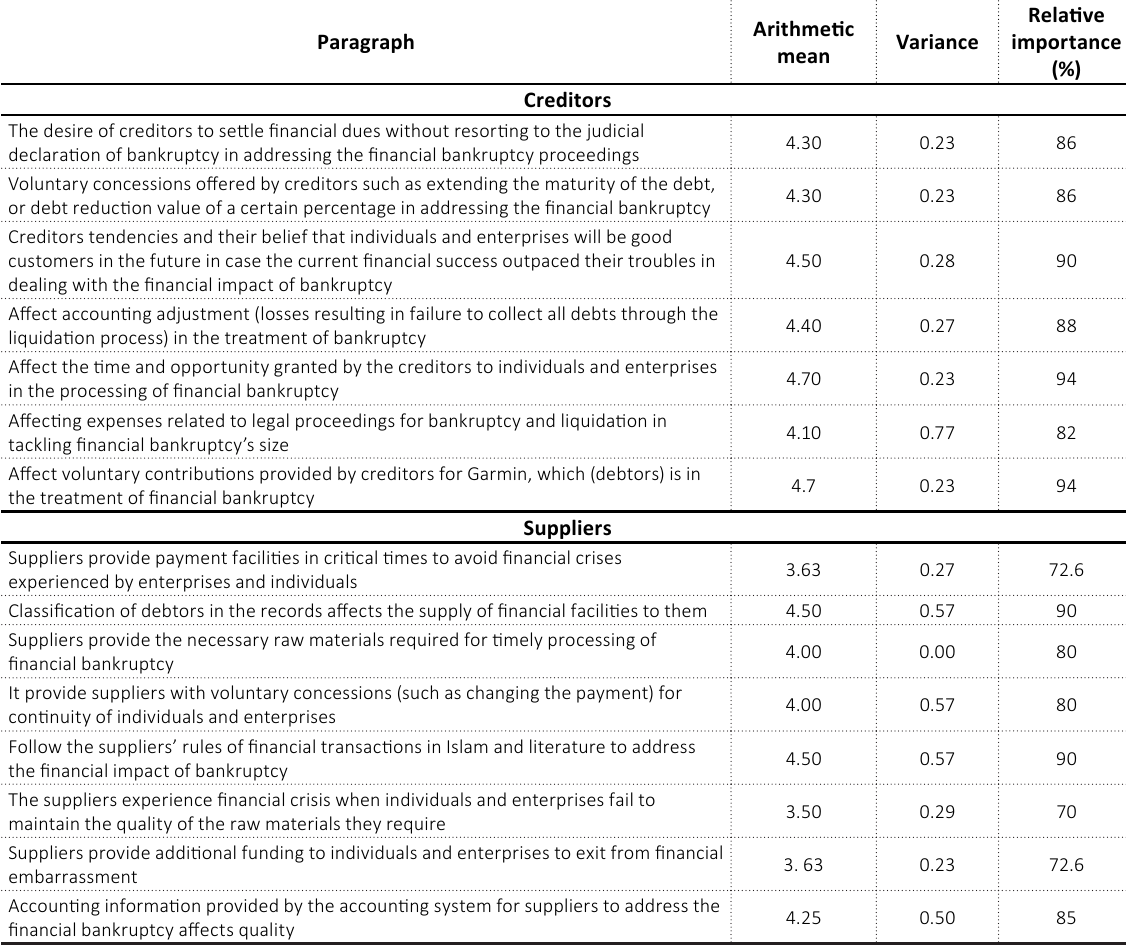
Table 4 (cont.). Arithmetic average contrast and the relative importance of the independent variables (administration, the size of Zakat, the size of other handouts, creditors, and suppliers) Relative Paragraph Arithmetic Variance importance mean (%) Creditors